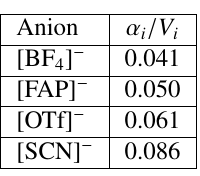
Table 2. α i / V i ratio of selected anions.